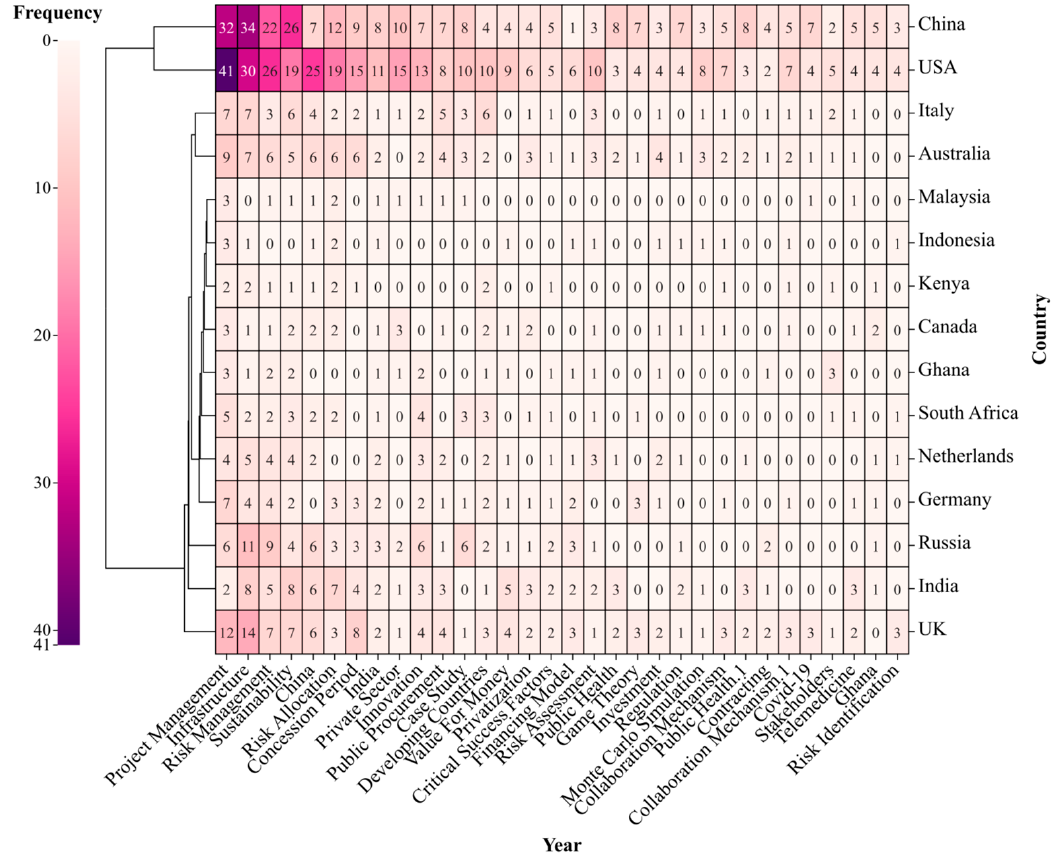
Figure 9. Coupled Biclustering Graph of Country and Keyword.